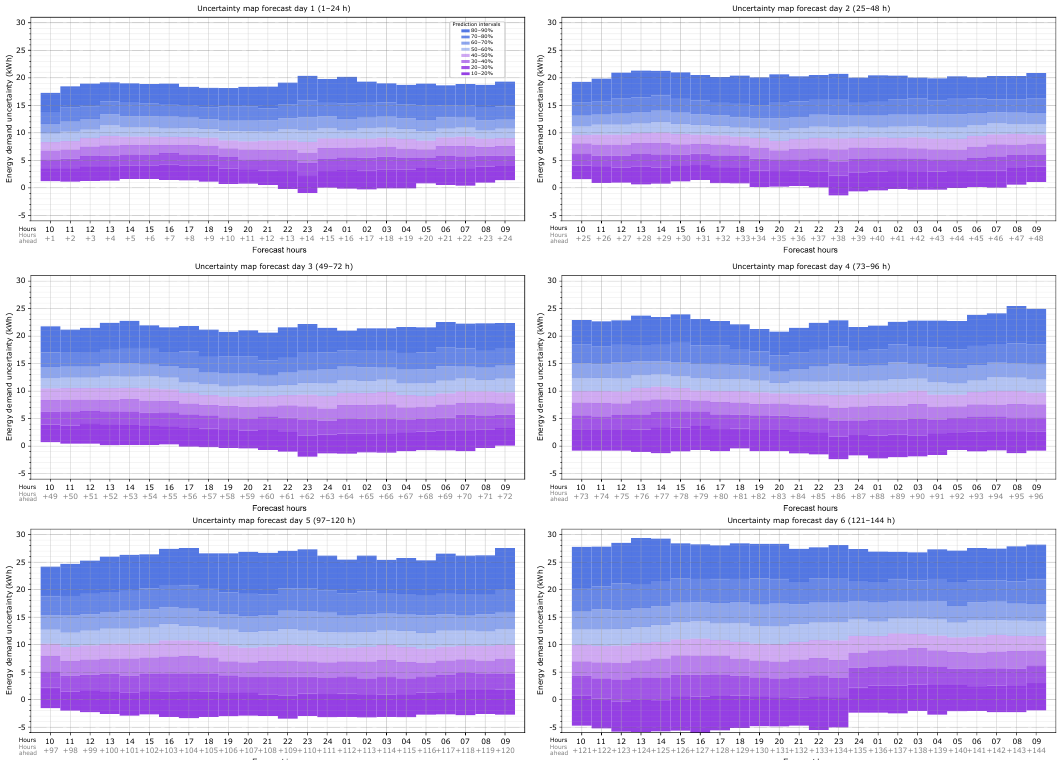
Figure 9. Probabilistic heating load forecast results: Hourly uncertainty map of the heating load forecast due to weather forecast data for 1 to 6 days ahead.